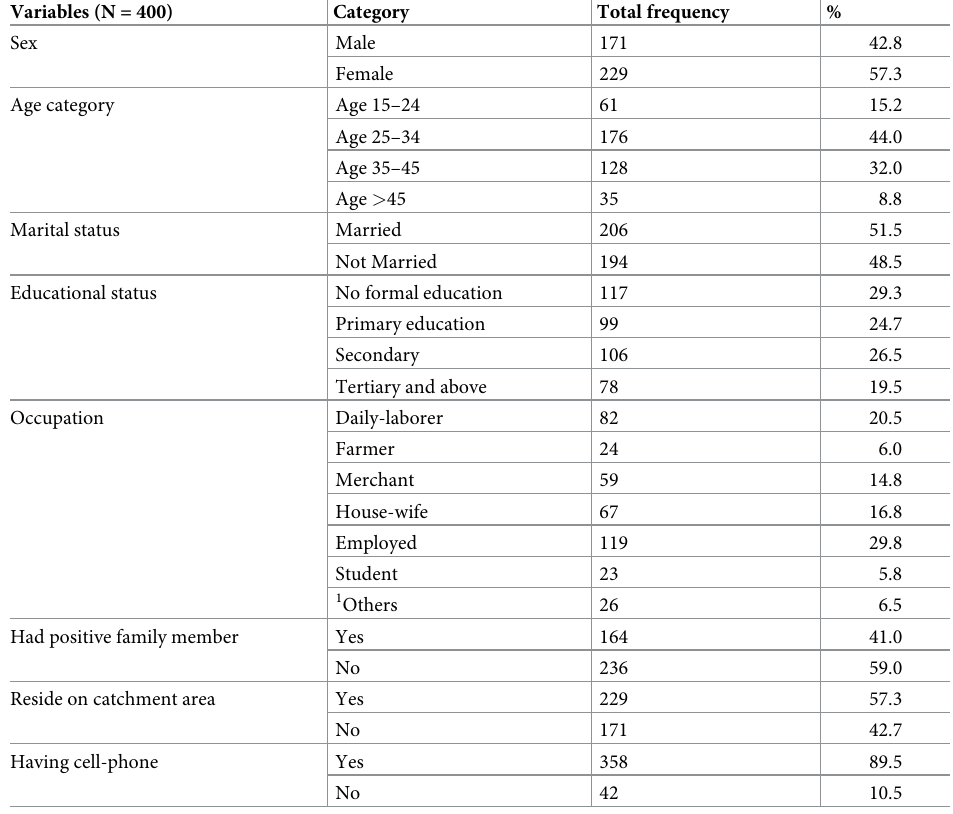
Table 1. Socio-demographic characteristics adults receiving ART at public health institutions in Bahir Dar city, Northwest